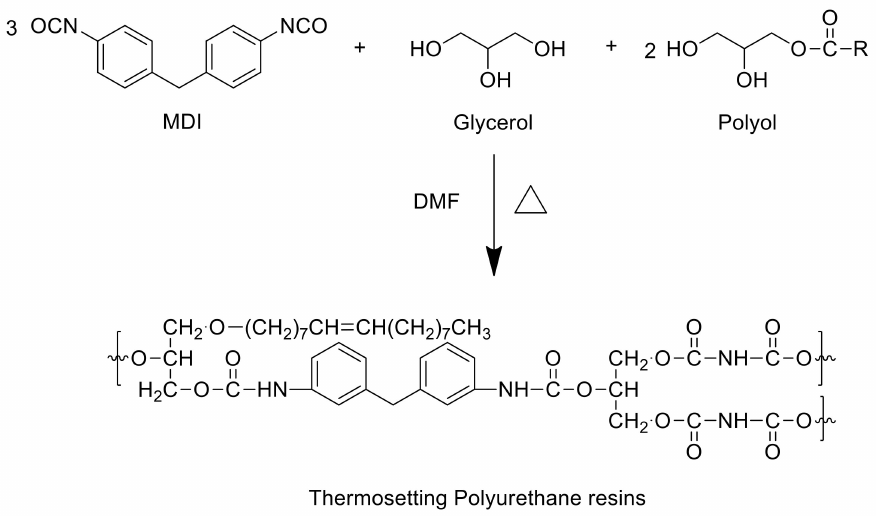
Figure 2. Thermosetting polyurethanes synthetic pathway (TSPUs) using pMDI, polyol, and glyc- erol